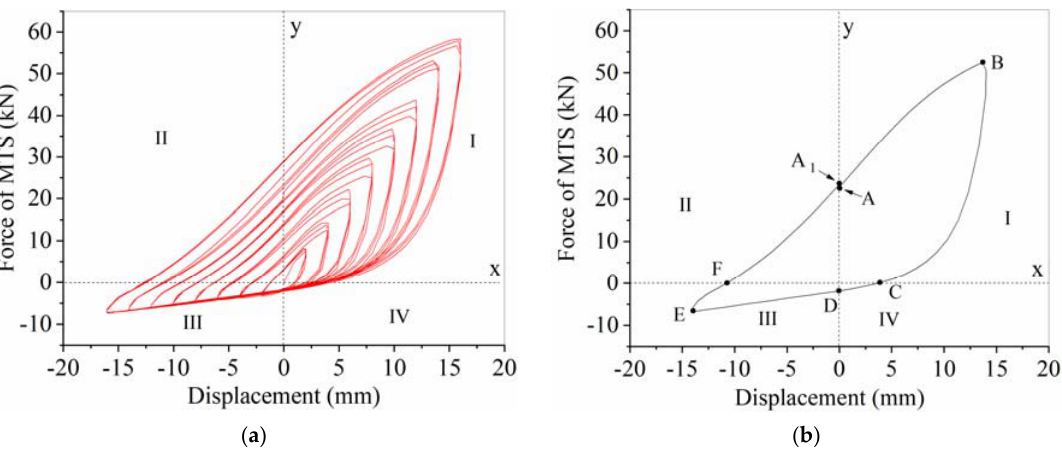
Figure 13. Hysteresis curves. ( a ) Hysteretic curves for the entire process. ( b ) Hysteretic curve for one cycle.